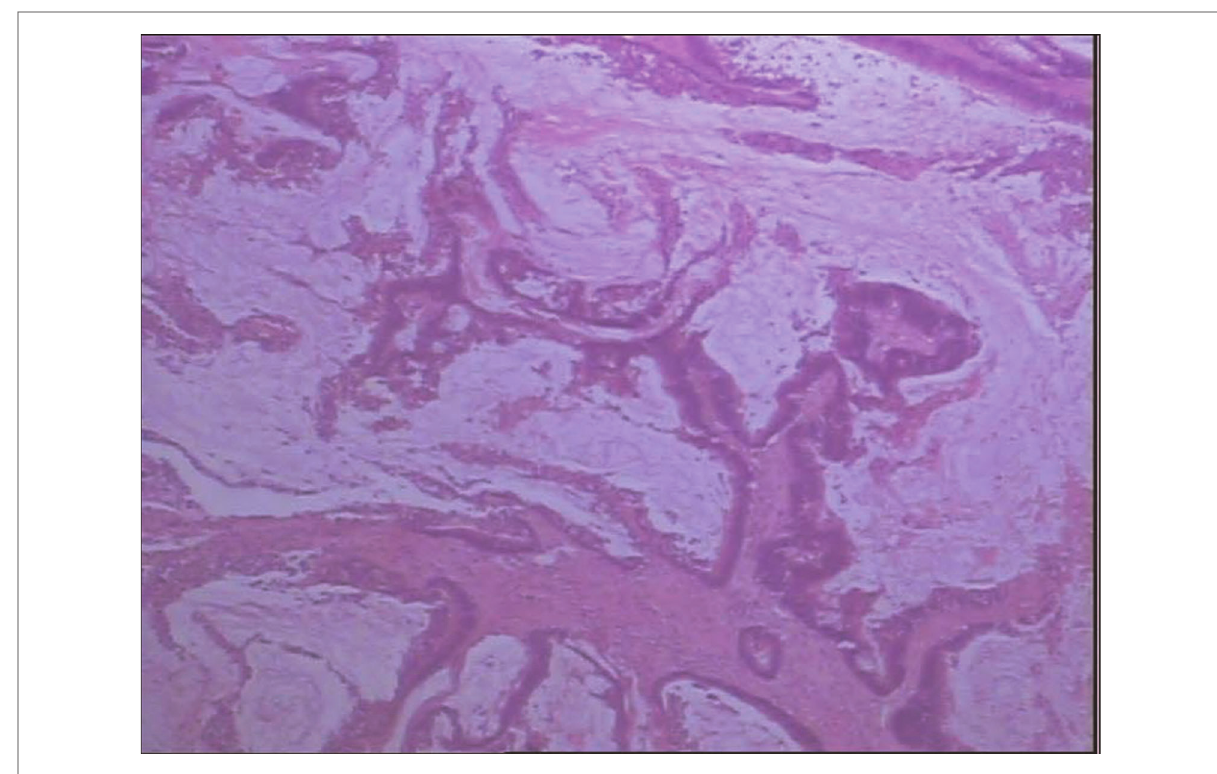
FIGURE 4 Postoperative pathological result revealed moderately differentiated adenocarcinoma in the right colon with full-thickness invasion (magni fi cation power: